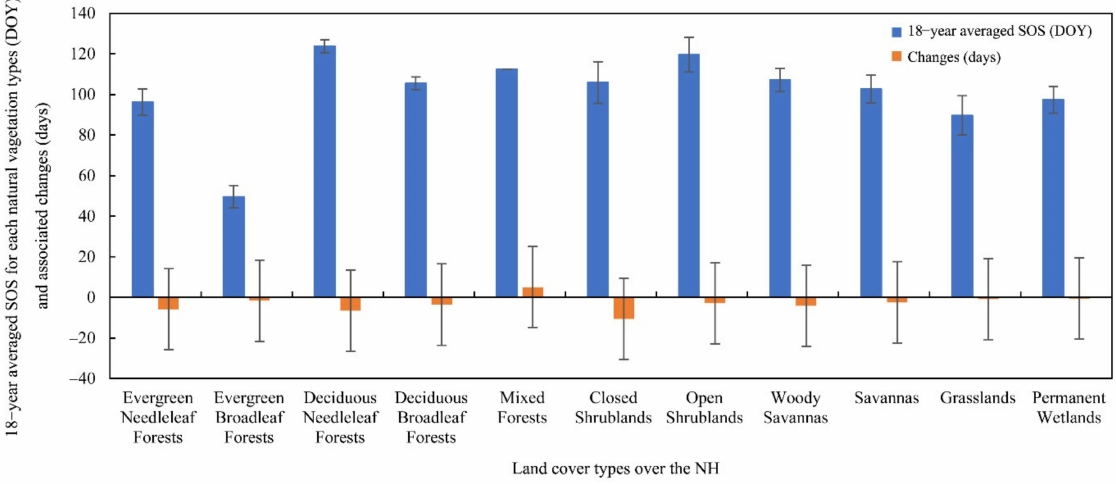
Figure 4. The 18-year averaged SOS for 11 natural-vegetation types and associated